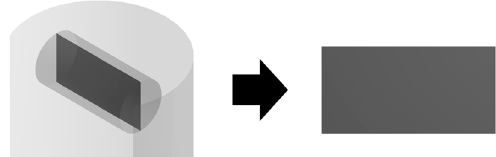
Figure 6. Cross-section surface for porous body ( Ω Figure 6. Cross ‐ section surface for porous body ( Ω ). Figure 6. Cross ‐ section surface for porous body ( Ω ).